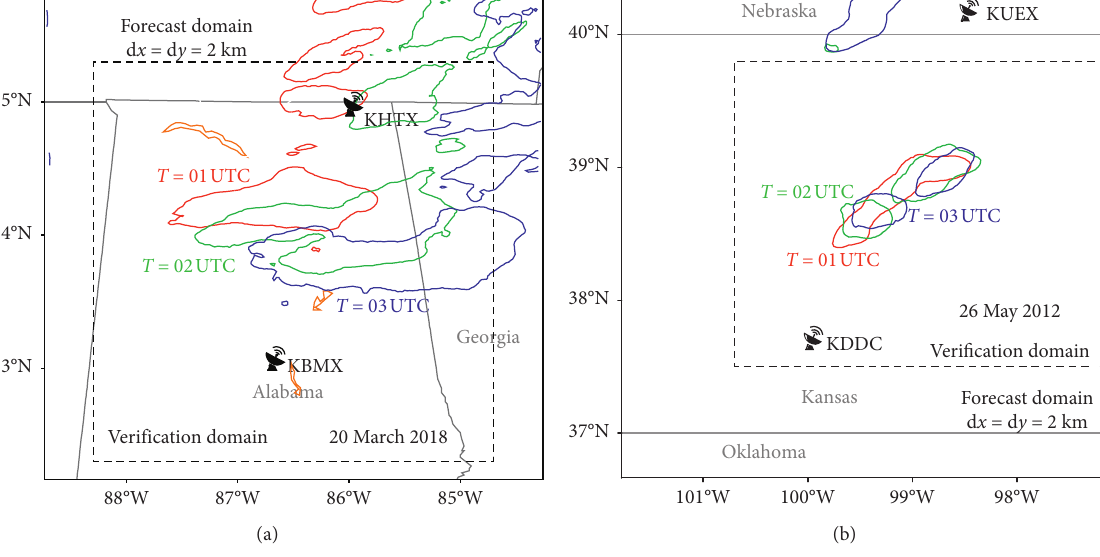
Figure 2: The forecast domains for the (a) 20 March 2018 and (b) 26 May 2012 cases, where the dashed rectangles mask the verification domains. The observed rainfall areas with precipitation greater than 5 mm · h − 1 are plotted for 01 UTC (red), 02 UTC (green), and 03 UTC (blue). The locations of KBMX, KHTX, KDDC, and KUEX are marked by radar